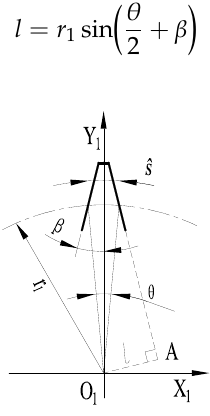
Figure 1. Tooth profile curve of the external gear.